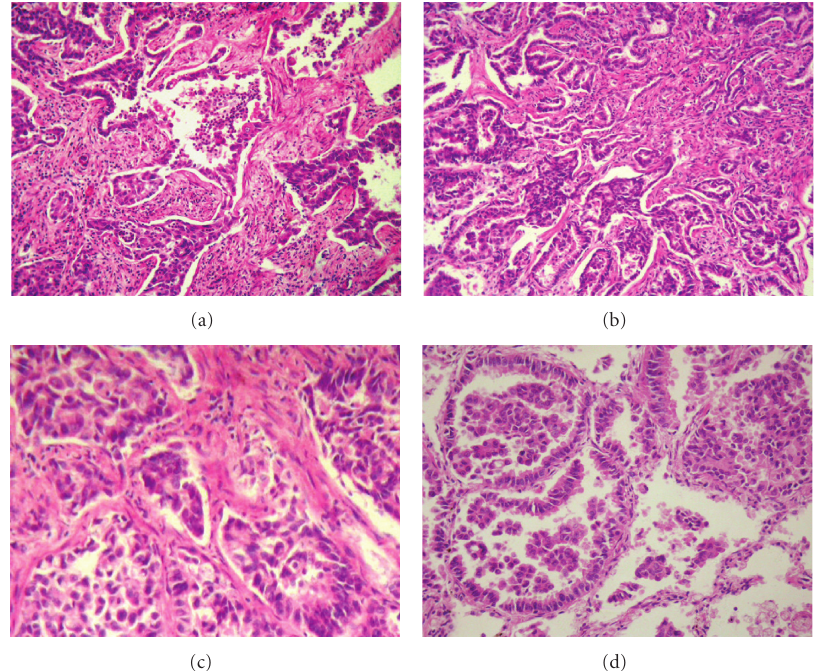
Figure 3: (a)–(c): Photomicrographs demonstrate active young fibroblast proliferation (fibrosis) and tumor cells that are entrapped within the central desmoplasia. (d): Photomicrograph shows neoplastic cells spreading along alveolar septa (lepidic growth) with preservation of the alveolar architecture (hematoxylin-eosin